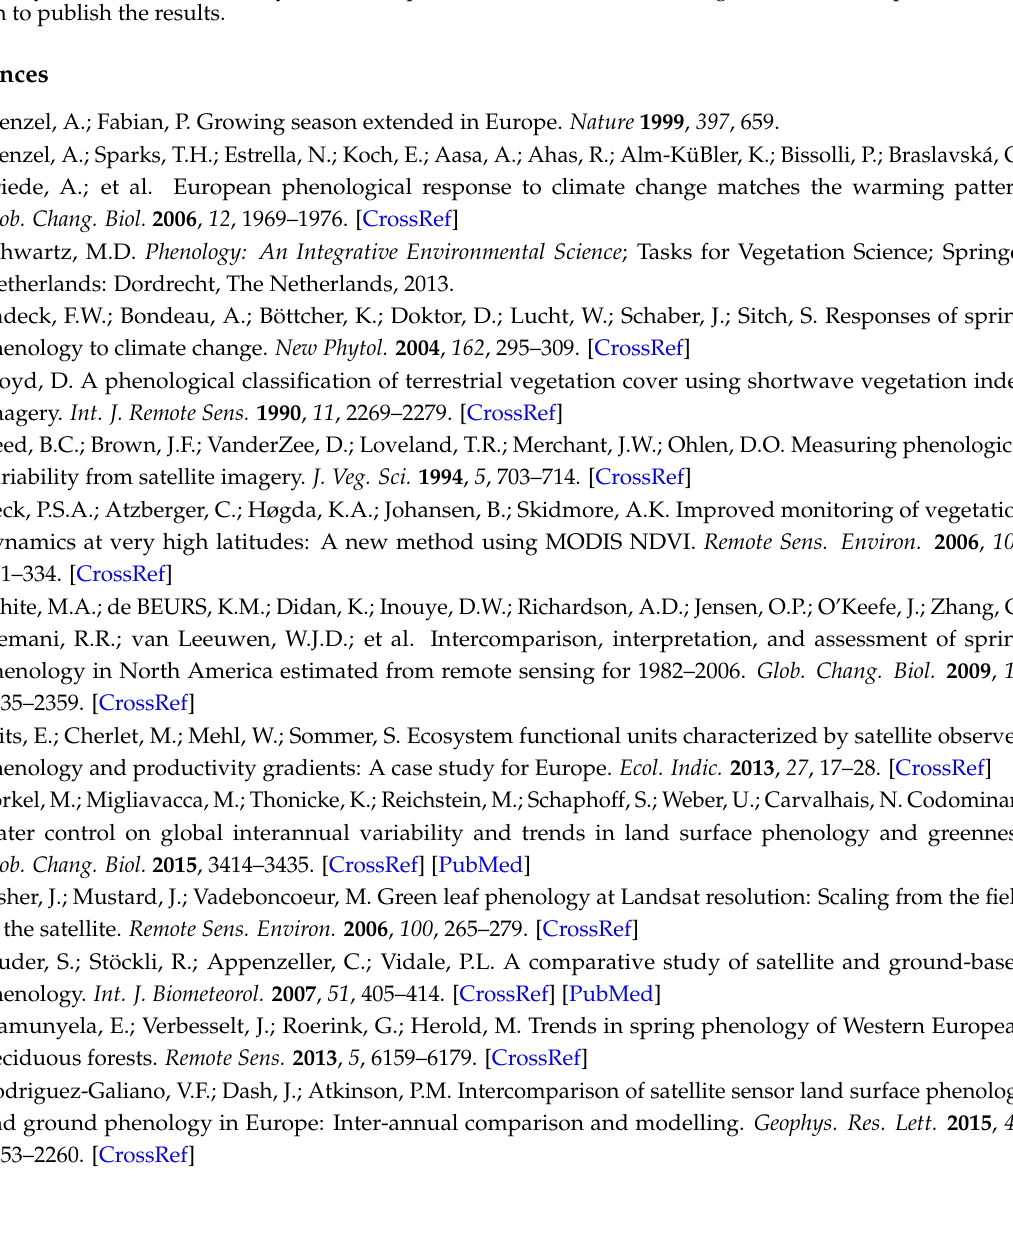
results-II, Figure S3: Double Log smoothing results-I, Figure S4: Double Log smoothing results-II, Figure S5: Time series of GP-SOS-I, Figure S6: Time series of GP-SOS-II and Table S1: showing Mean-SOS and trends of species-specific GP and their ID numbers